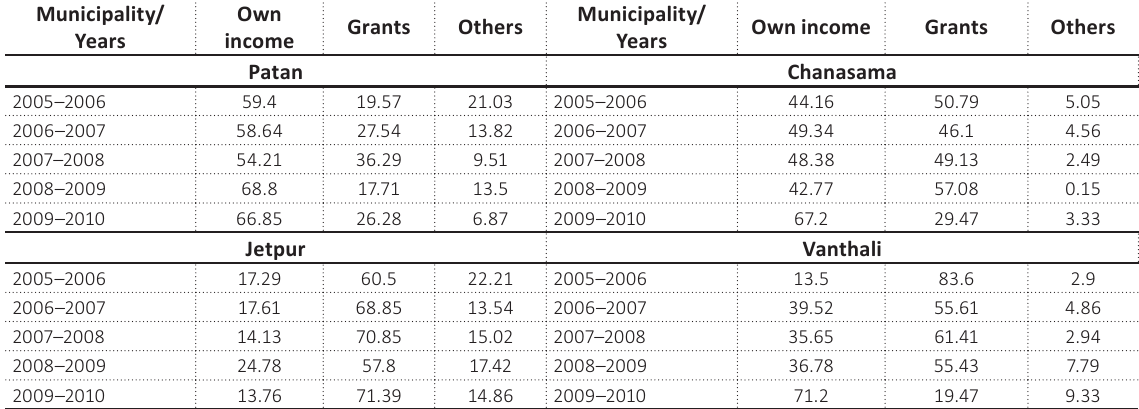
Table 4. Distribution of total income (in